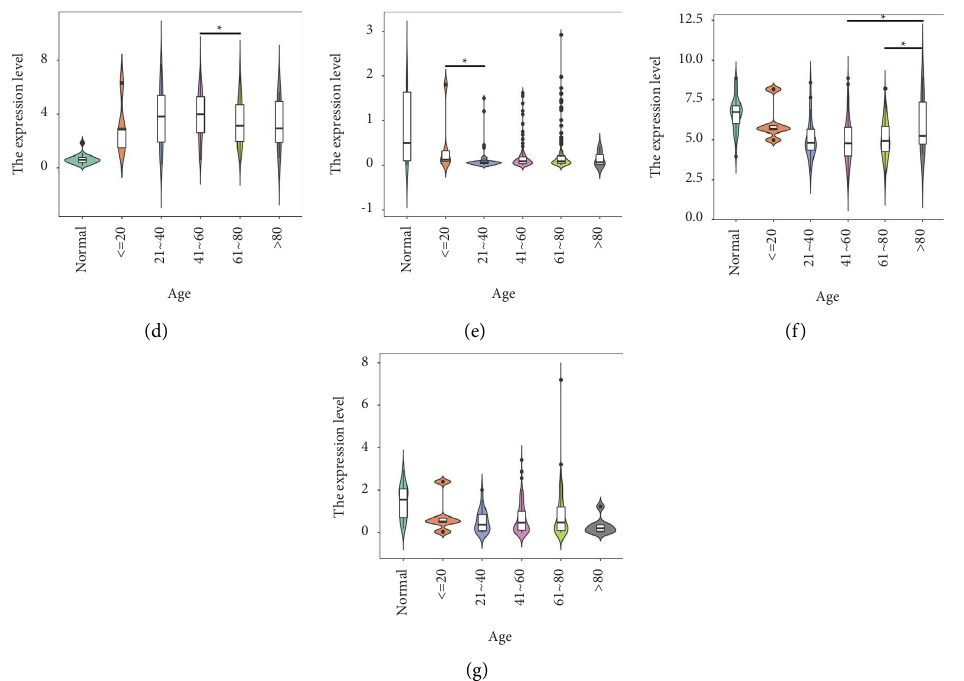
Figure 4: Expression of important DEGs in HCC patients with diferent ages: (a) MAFG-DT; (b) GSTZ1; (c) GPRIN1; (d) MYBL2; (e) LINC00907; (f) CCN1; (g) GSTM5 ( ∗ P < 0 .